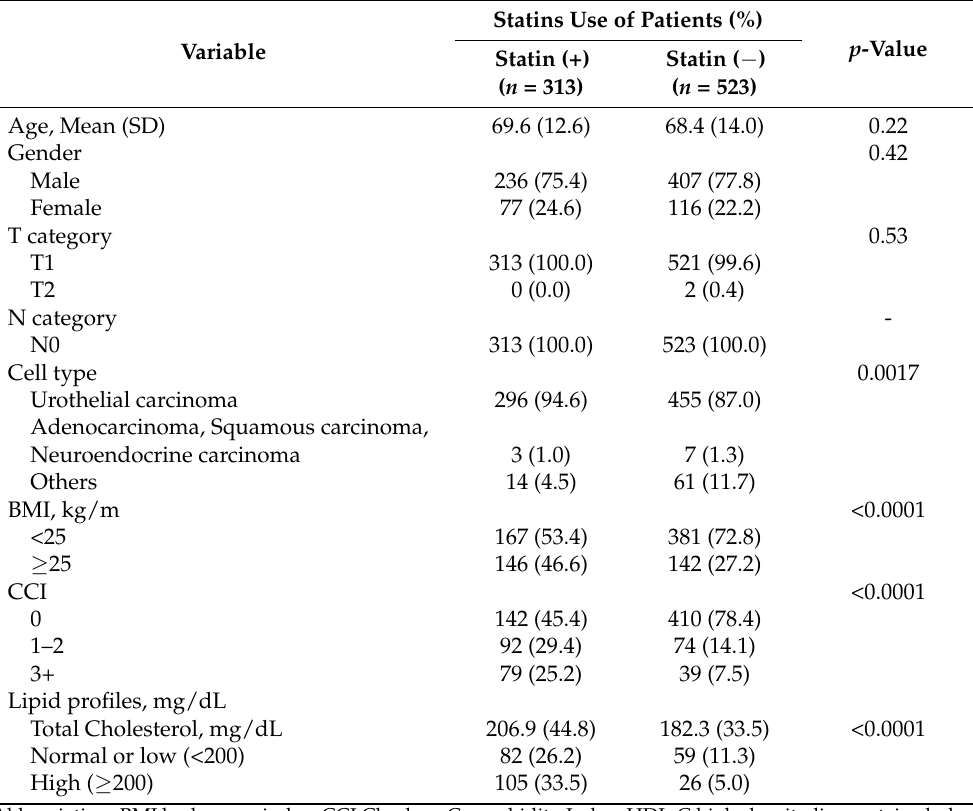
Table 1. Characteristic of BLCA stage 0-I patients ( n =